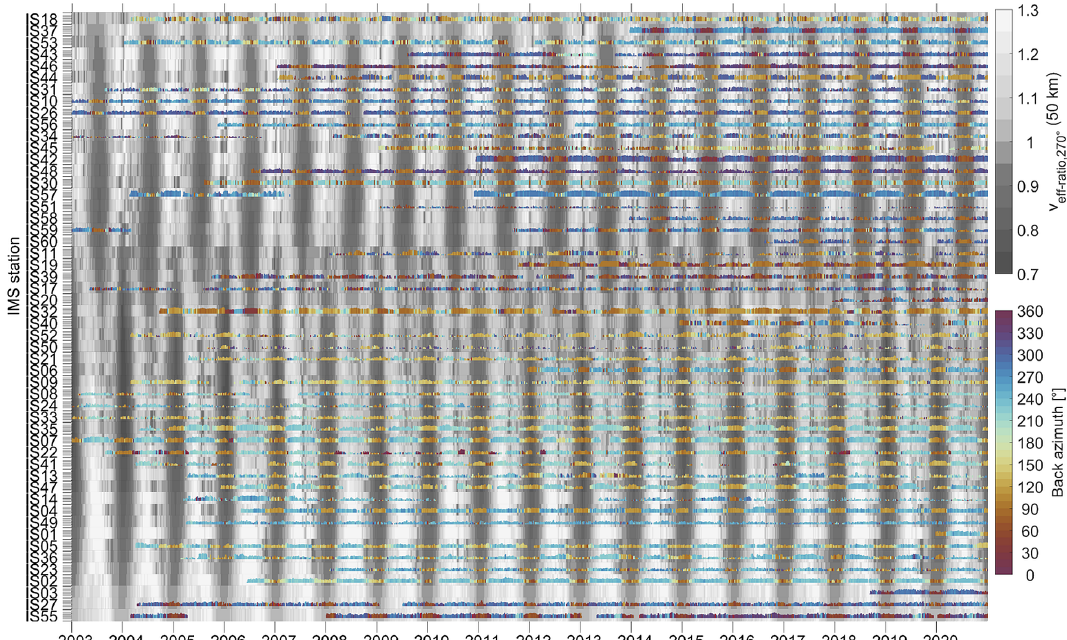
Figure C3. As in Fig. 11 but for the mb_hf product (0.45–0.65Hz). As the vertical extent of each colored line denotes the number of